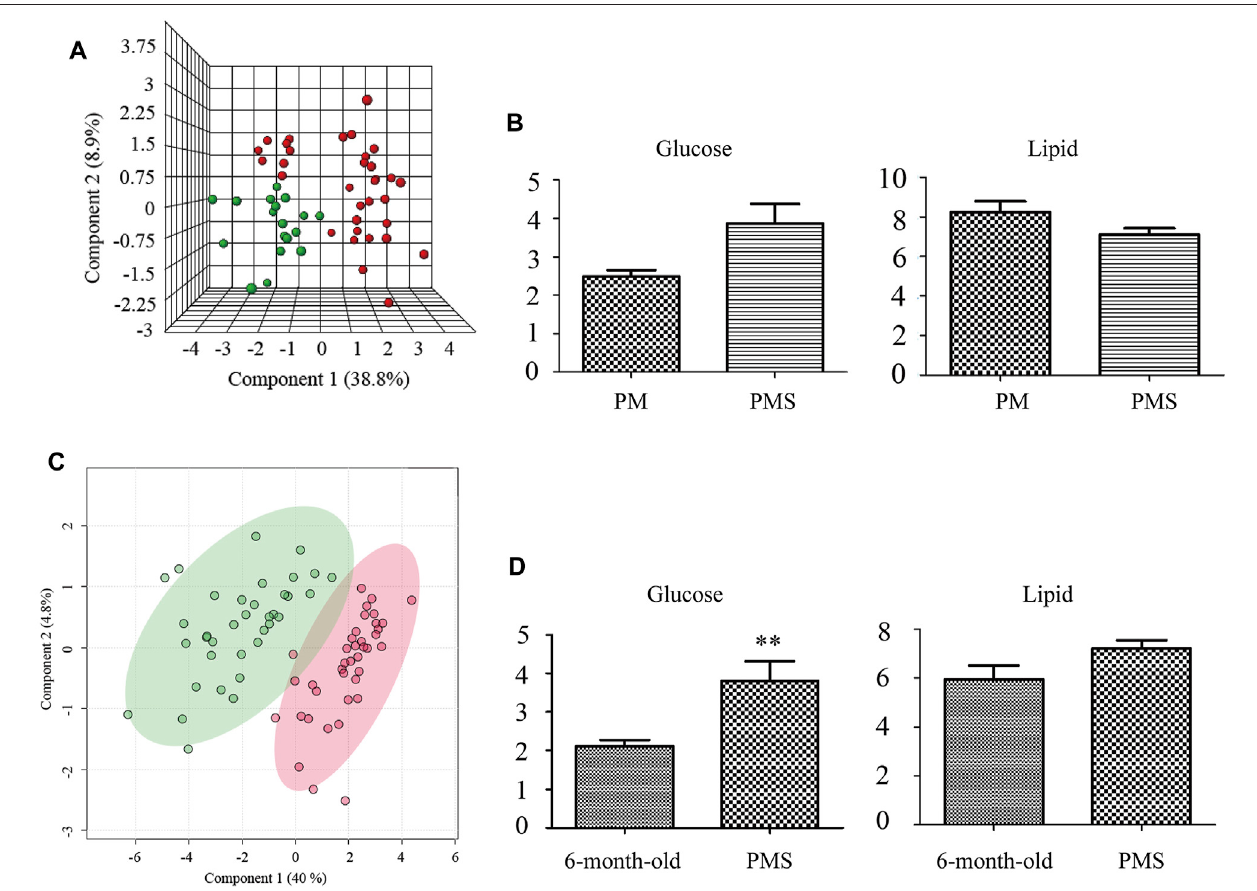
FIGURE 2 | Metabolomic pro fi les of 6-month-old, PM and PMS rats. (A) 3D representation of PLS-DA analysis of the PM (green) and PMS rats (red). The metabolomic pro fi les of the PMS rats changed signi fi cantly. (B) Transition from perimenopause to PMS, the levels of glucose were upregulated, while the levels of lipid weredownregulated. (C) PLS-DA analysisofmetabolomicpro fi le from theplasmaof6-month-old rats (green)and PMS rats(red). (D) Compared with6-month-old rats, the levels of glucose and lipid were upregulated. p < 0.01 (**).